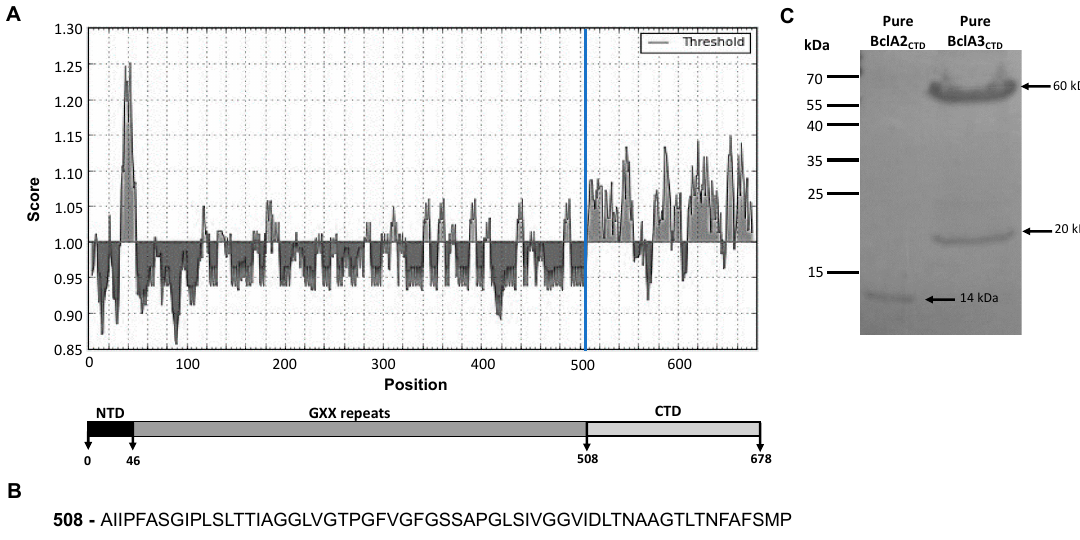
Figure 1. Analysis of the glycoprotein BclA3 from C. difficile R20291. ( A ) The C-terminal domain (CTD) of BclA3 (last 170 amino acid residues) shows higher B cell epitope propensity score compared with the rest of the protein (Kolaskar & Tongaonkar Antigenicity Method from Immune epitope database). The X- and Y-axes represent the sequence position and antigenic propensity score, respectively. The threshold value was generated by default by Immune epitope database (http://tools.iedb.org/bcell/). The regions above the threshold are antigenic. ( B ) The correspondent aminoacidic sequence of BclA3 CTD is shown. ( C ) Coomassie stained SDS-PAGE gel; 2 and 5 µg of purified C-terminal domains of the exosporium proteins BclA2 and BclA3 were loaded, respectively. BclA2 CTD migrates as 14 kDa band while BclA3 CTD migrates as 2 bands of approximately 20 and 60 kDa.